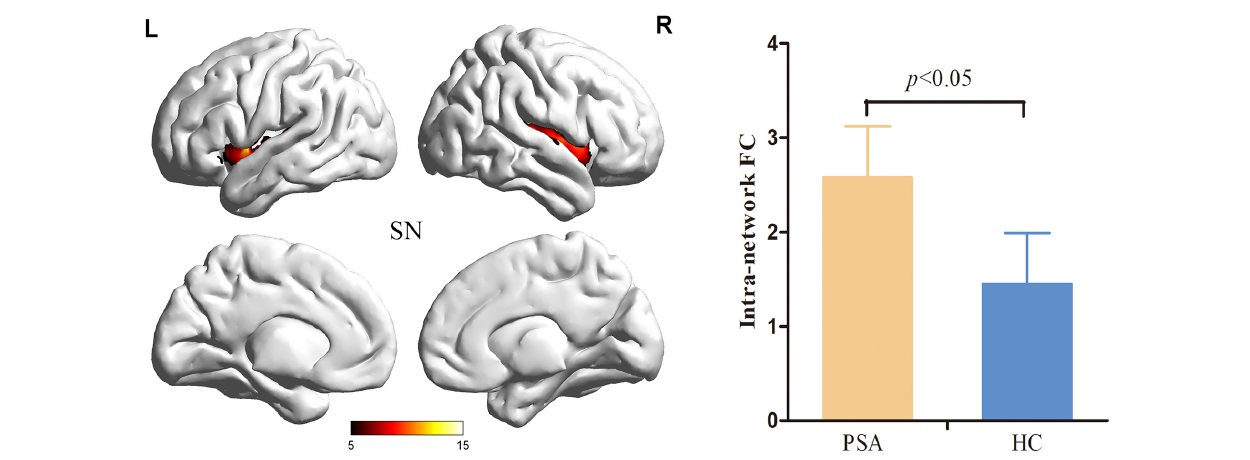
FIGURE 2 | Salience Network with significant changes in intranetwork FC in patients with PSA. SN, salience network; FC, functional connectivity; PSA, post-stroke aphasia.